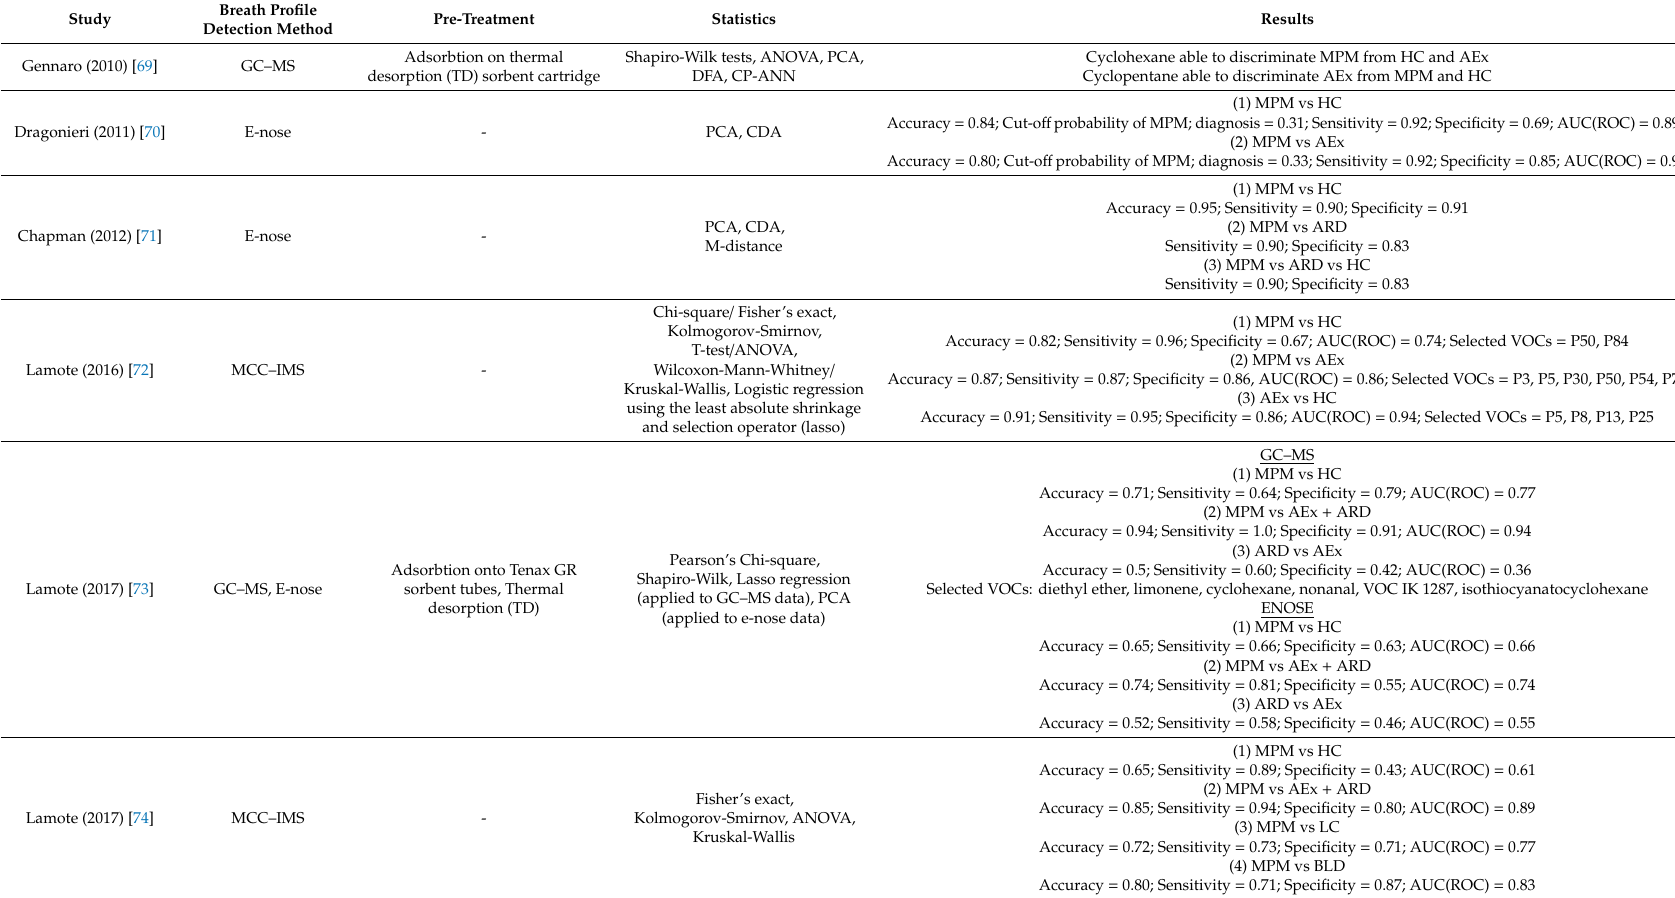
Table 4. Overview of studies regarding breath detection and statistical methods